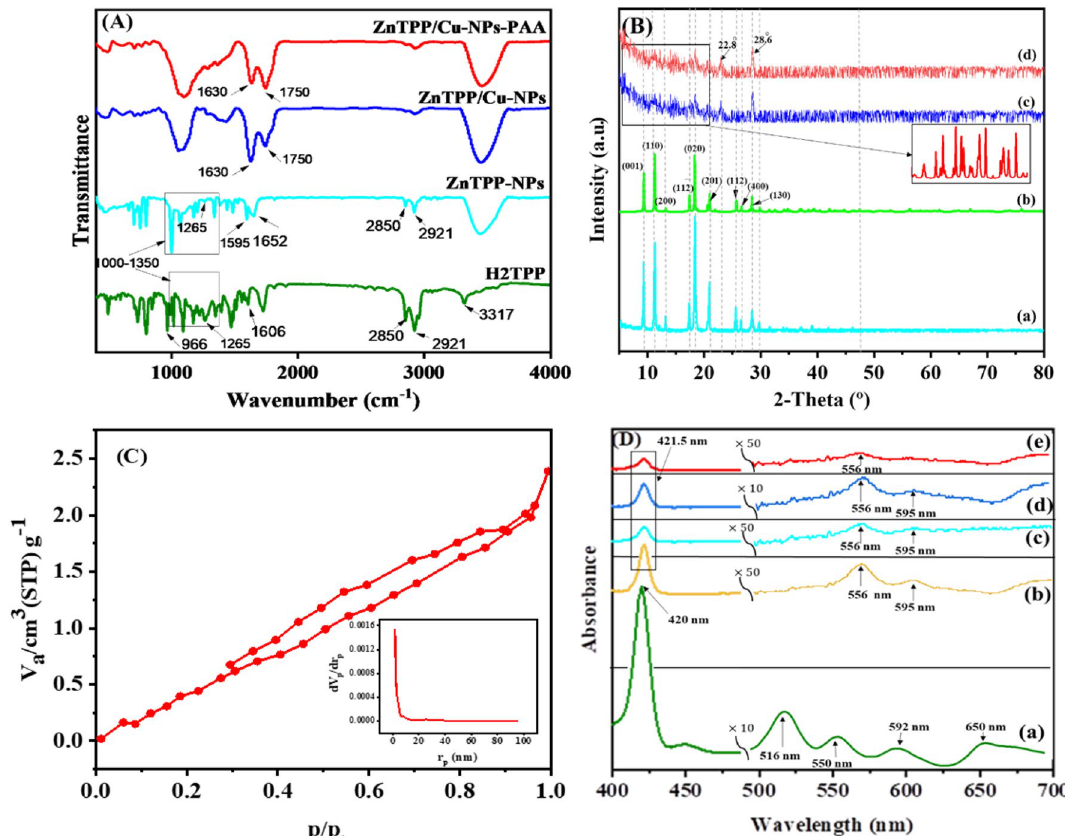
Figure 2. FT-IR, PXRD, BET-BJH, and UV–Vis of prepared porphyrin-based